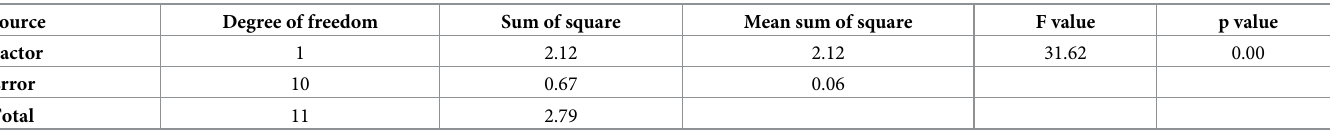
Table 11. ANOVA results for business performance.